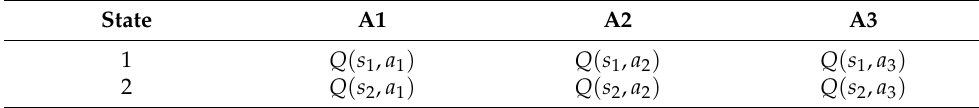
Table 3. Q-table for a single